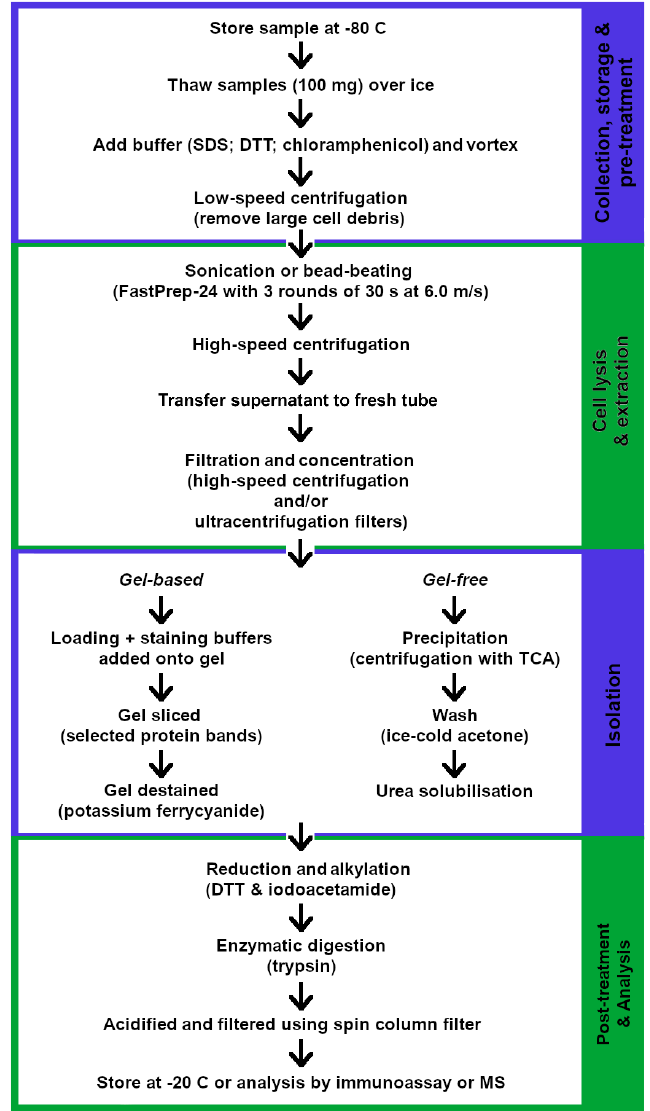
Figure 4. A combination summary of the most efficient methods in extracting microbial protein and peptide components from fecal specimens.